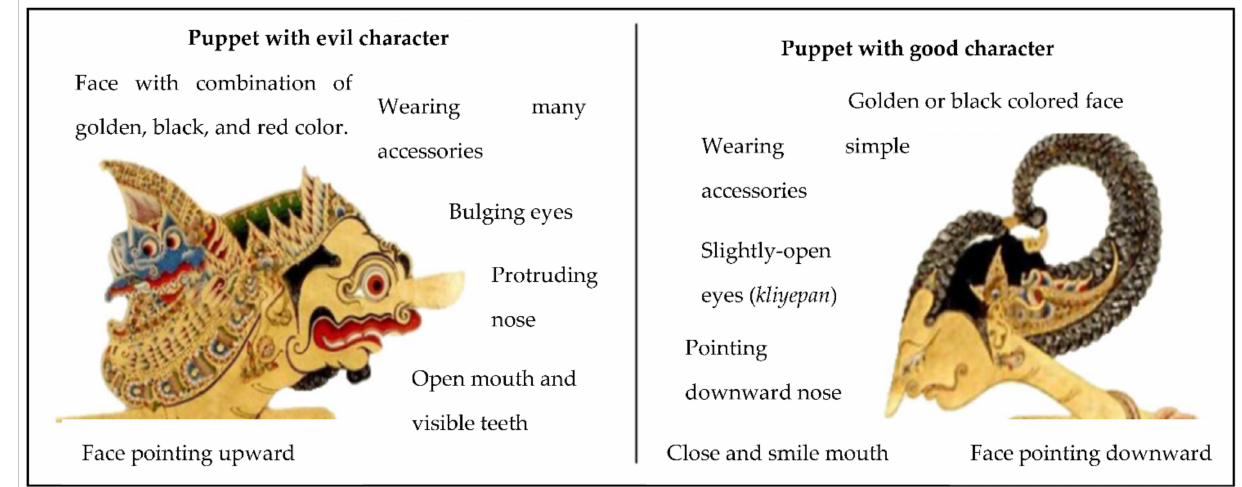
Figure 2. The puppet character is recognized from its